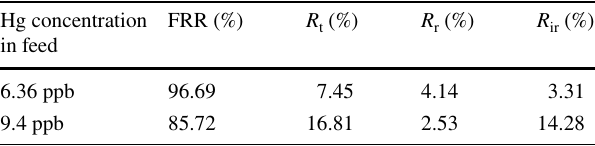
Table 3 Antifouling parameters of c-GO-PEI treating Hg-containing